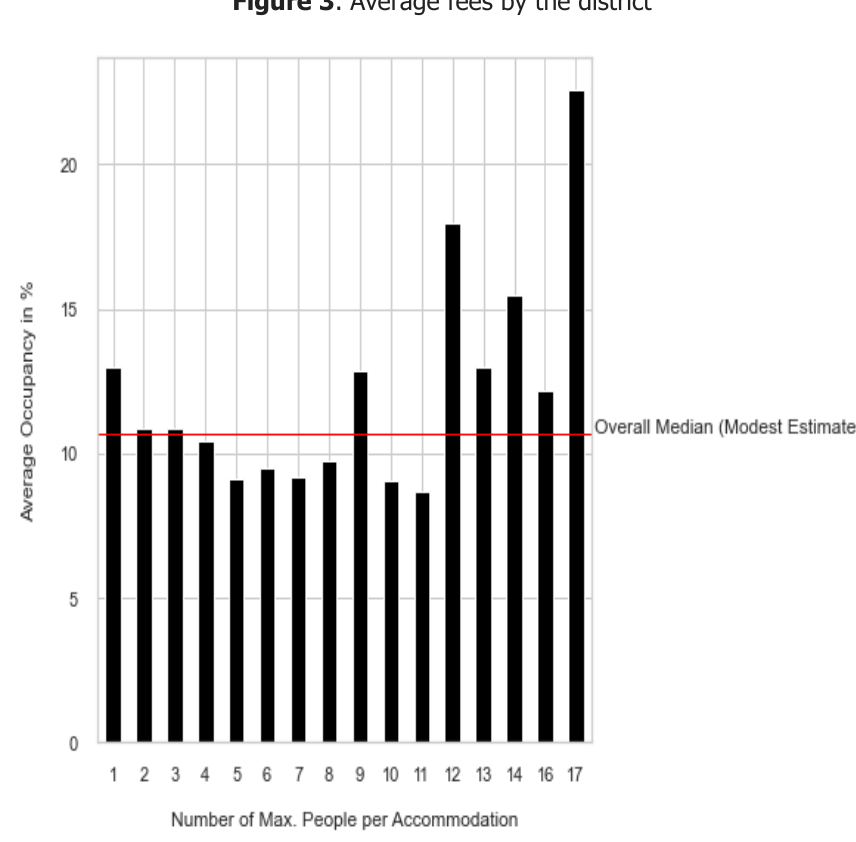
Figure 4 . Average Occupancy by